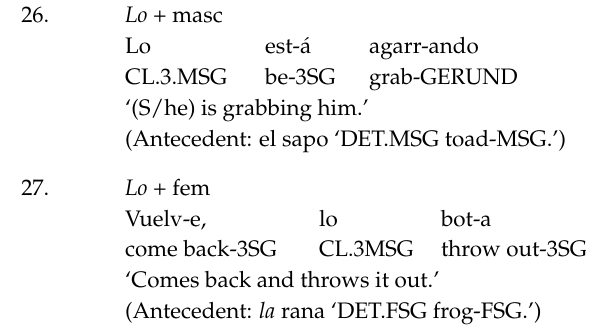
Figure 1. Gender of antecedents and doubled determiner phrases (DPs) of the clitic le in percentages.